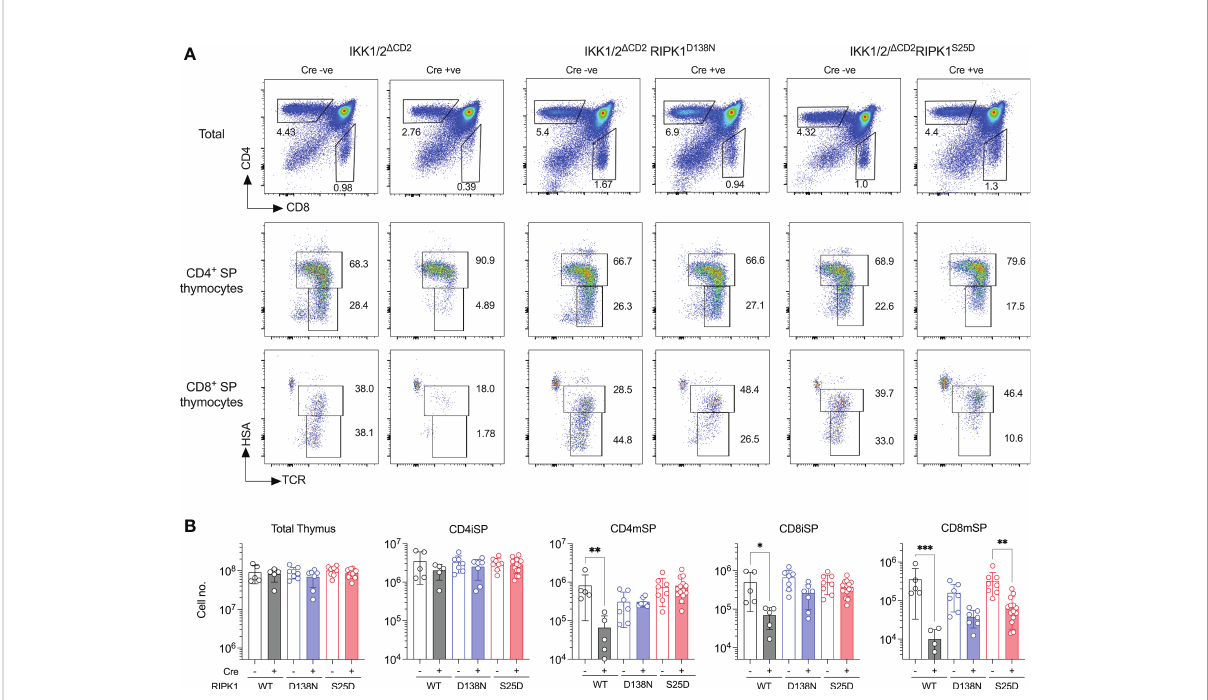
FIGURE 3 RIPK1 S25D rescues IKK de fi cient thymocytes from cell death in vivo . Single cell suspensions were prepared from the thymus of Cre -ve (n=5) and Cre +ve (n=5) IKK1/2 D CD2 , Cre -ve (n=7) and Cre +ve (n=7) IKK1/2 D CD2 RIPK1 D138N and Cre -ve (n=8) and Cre +ve (n=14) IKK1/2 D CD2 RIPK1 S25D mice, enumerated and analyse by fl ow cytometry. (A) Flow plots show phenotype of the indicated populations (rows) from the indicated mice (columns) and gates used to de fi ne immature HSA hi CD4 + TCR hi SP (CD4iSP), mature HSA lo CD4 + TCR hi SP (CD4mSP) immature HSA hi CD8 + TCR hi SP (CD8iSP) and HSA lo CD8 + TCR hi SP (CD8mSP) thymic subpopulations. (B) Bar charts show the total cell numbers for the indicated populations recovered from different strains. Data are pooled from fi ve independent experiments. Mann-Witney student ’ s t test. *p < 0.05, **p < 0.01, ***p <